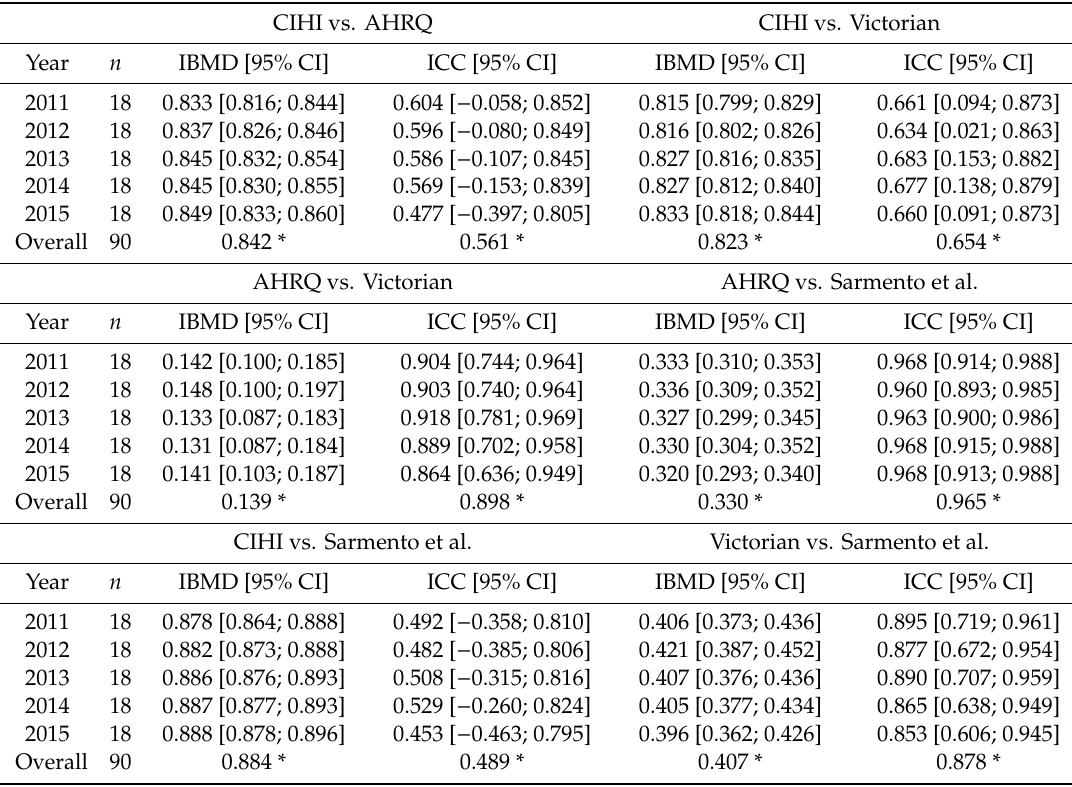
Table 5. Comparison of Di ff erent Pairs of Lists in Terms of Information-Based Measure of Disagreement (IBMD) and Intraclass Correlation Coe ffi cient (ICC). CIHI vs. AHRQ CIHI vs.